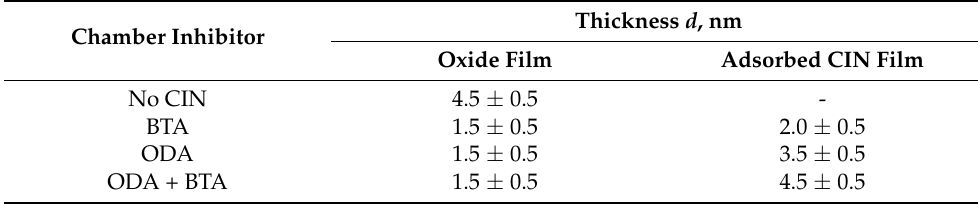
Table 3. Effect of copper chamber treatment on the thickness of surface films. T CT = 100 °C, and τ CT = 60 min.